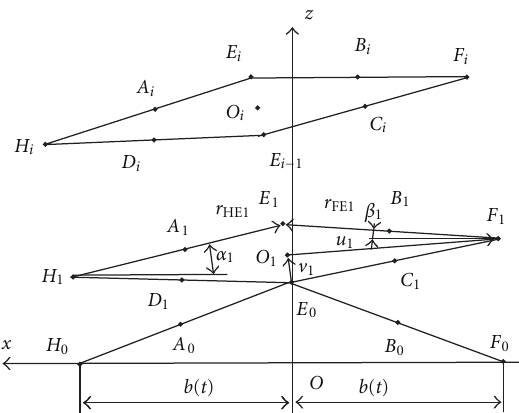
Figure 6: Deformations of tiers during